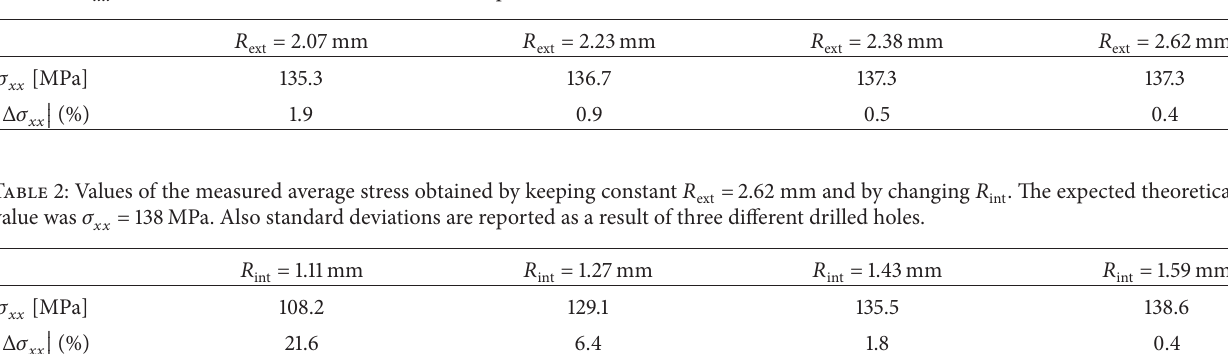
. The expected theoretical ext